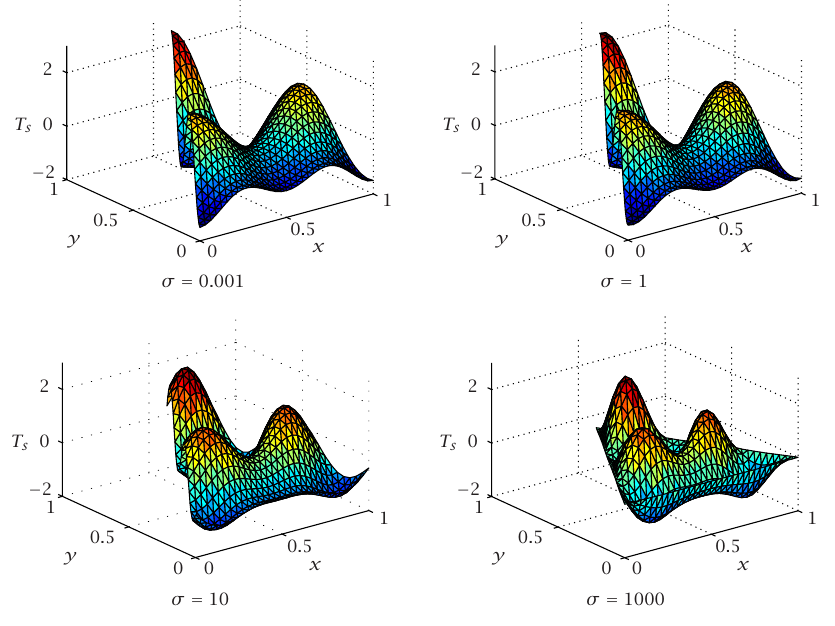
Figure 7.4 . The ( 1 , 2 ) symmetric mode.